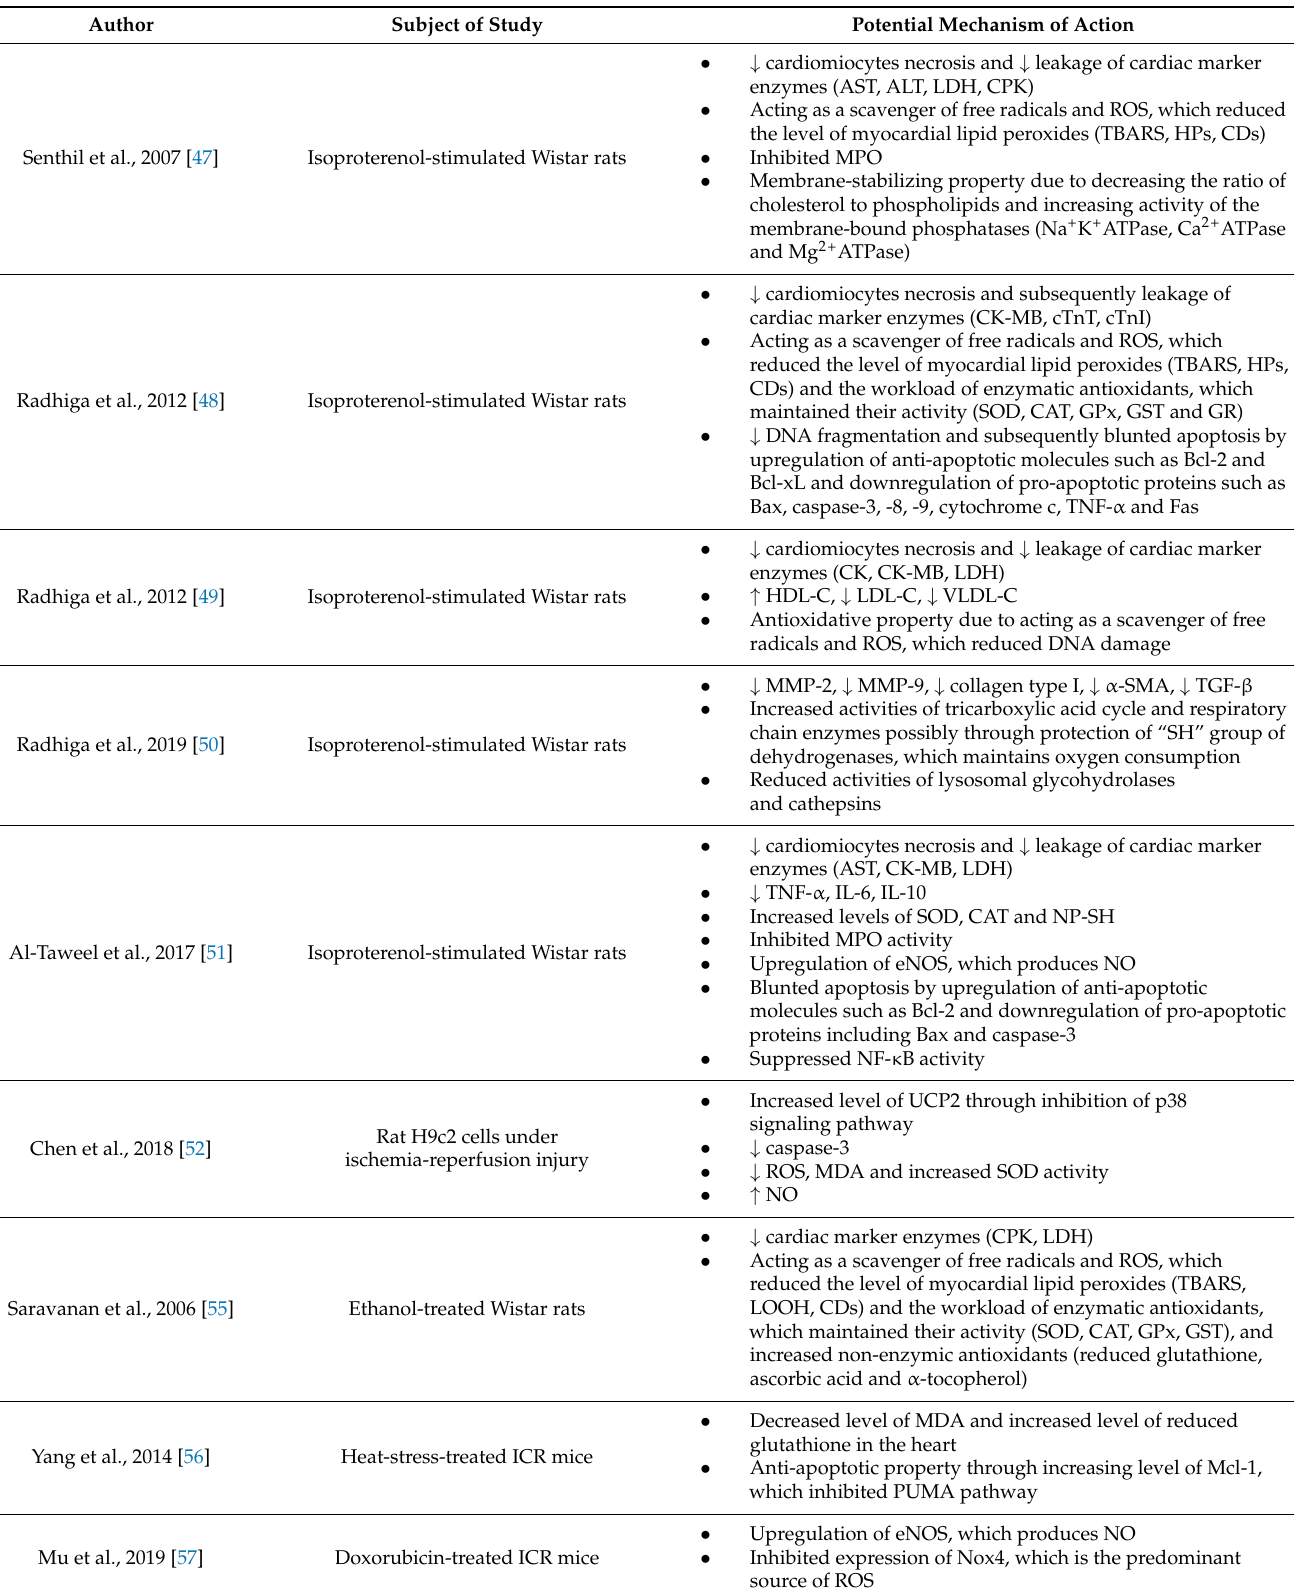
Table 2. Ursolic acid—effects and proposed mechanisms of its activity in